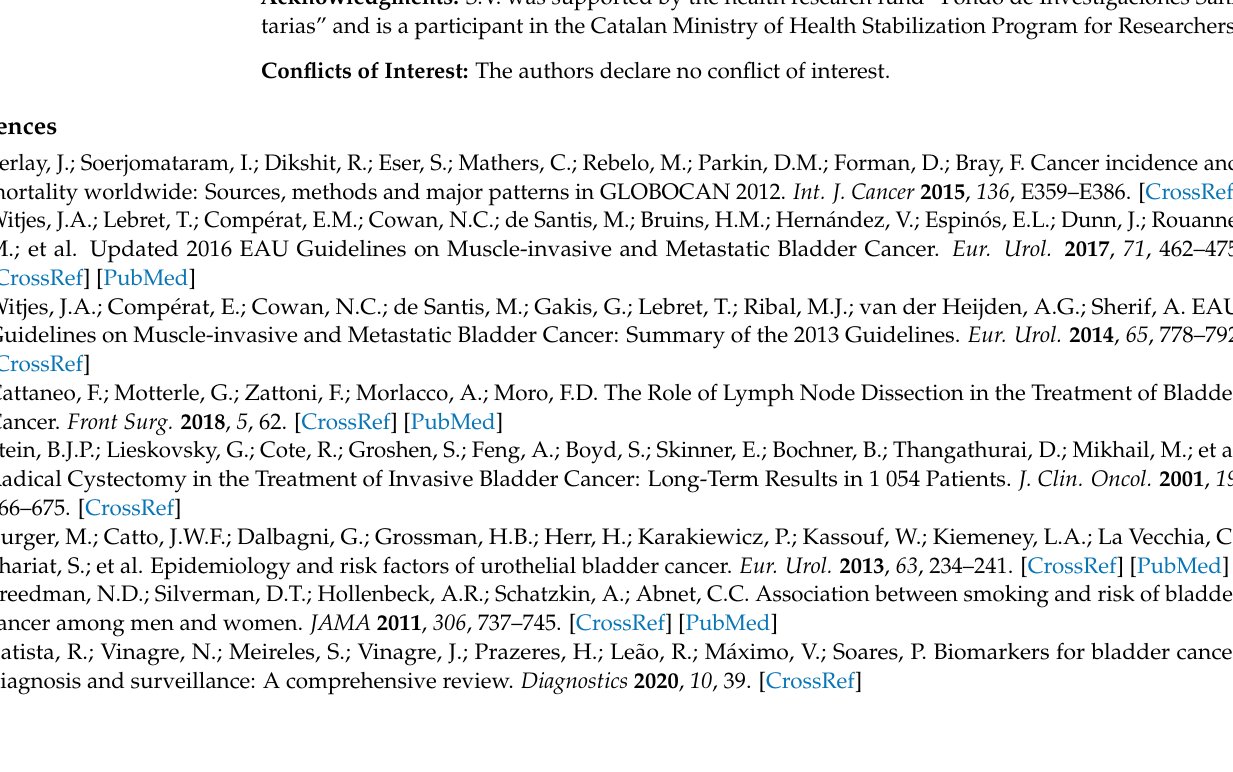
study; Figure S2: Gating hierarchy of a representative sample of urine cells showing how doublets and dead cells were excluded in the flow cytometry analysis. (A) Urine cells were analysed by flow cytometry without Violet dead Cell and without antibodies. (B) Urine were analyzed by flow cytometry with Violet dead Cell and anti-CD45 APC Vio770 and anti-CD326 PE Vio770 antibodies; Figure S3: Phenotyping of (A) urine and (B) blood leukocytes. Gated populations of urine based on viable cells, Lymphocyte population CD4+ and CD8+ based on the expression of CD3 and CD8. Expression of PD-1 and PD-L1 based on the limit detection determined by FMO); Table S1. The composition of urine at the time of RC time is associated with the recurrence of LN ( − ) in